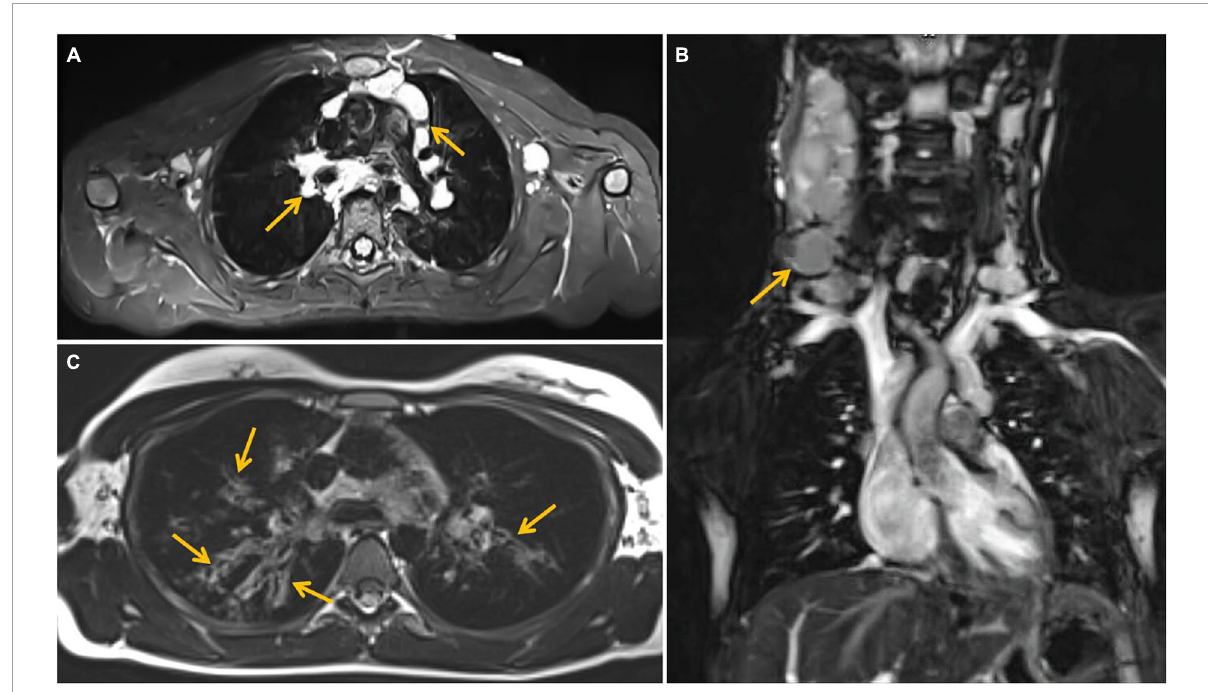
FIGURE3 Magnetic resonance imaging (MRI) examination of the chest. (A) T2 -weighted Short-TI Inversion Recovery (STIR) axial image showing enlarged perivascular lymph nodes (marked with arrows), (B) coronal image—enlarged cervical lymph nodes (marked with an arrow). (C) T2-weighted blade axial image—bronchiectasis (marked with arrows) in upper lobes of both lungs, more severe on the right side.